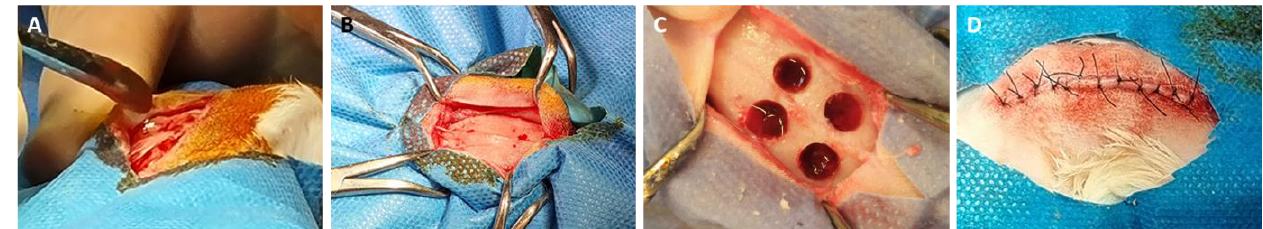
Figure 9. Step-by-step process of the surgical procedure. ( A ) The skin on the top of the cranium was disinfected and an incision was made from the nasal bone to the mid-sagittal crest. ( B ) The soft tissue was deflected and fixed, and the periosteum was removed. ( C ) Four defects were marked in the rabbit’s calvaria with a 6.00 mm trephine bur. To preserve the dura, they were then completed with rose burrs of 5.00 mm in diameter, followed by a burr with a 1.00 mm diameter. ( D ) Scaffolds were placed in the created bone defects and the wound was closed with sutures.